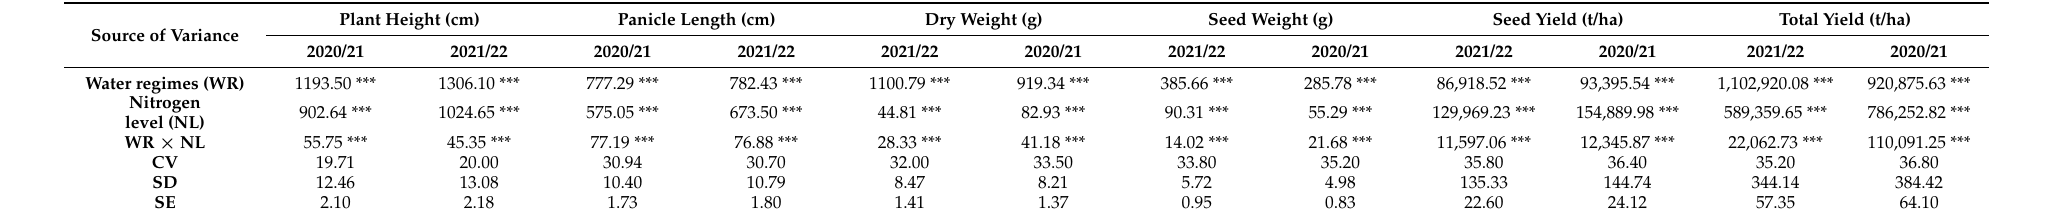
Table 5. Statistical analysis of six agronomic and yield traits of quinoa as affected by different irrigation regimes and nitrogen levels for both growing seasons (2020/21 and 2021/22) at Arab El-Awammer Research